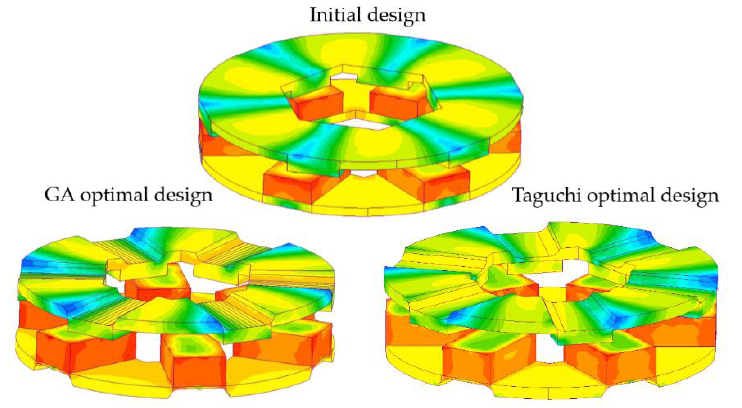
Figure 9. Comparison of initial and optimal design geometries. Table 7. Discs thicknesses values for initial and optimal designs.